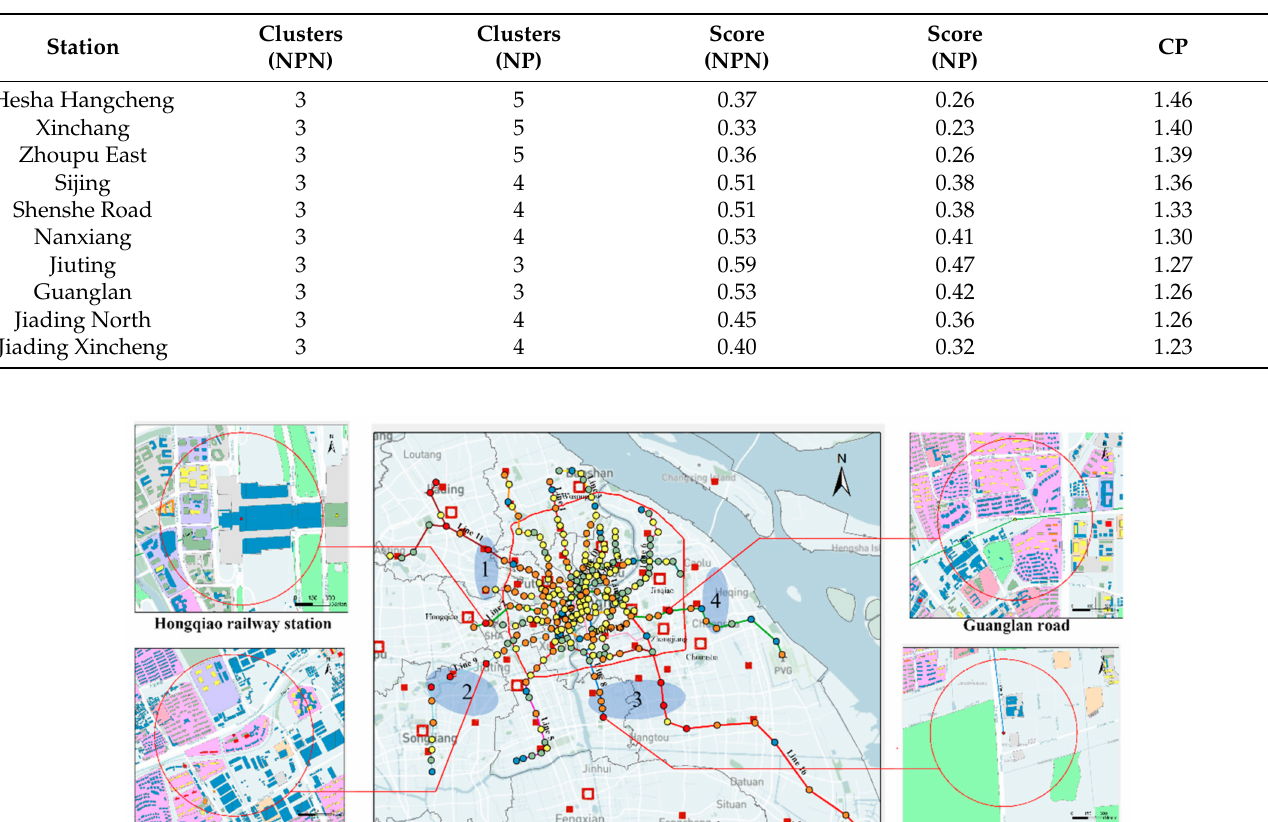
Table 7. Top 10 stations of carrying pressure.